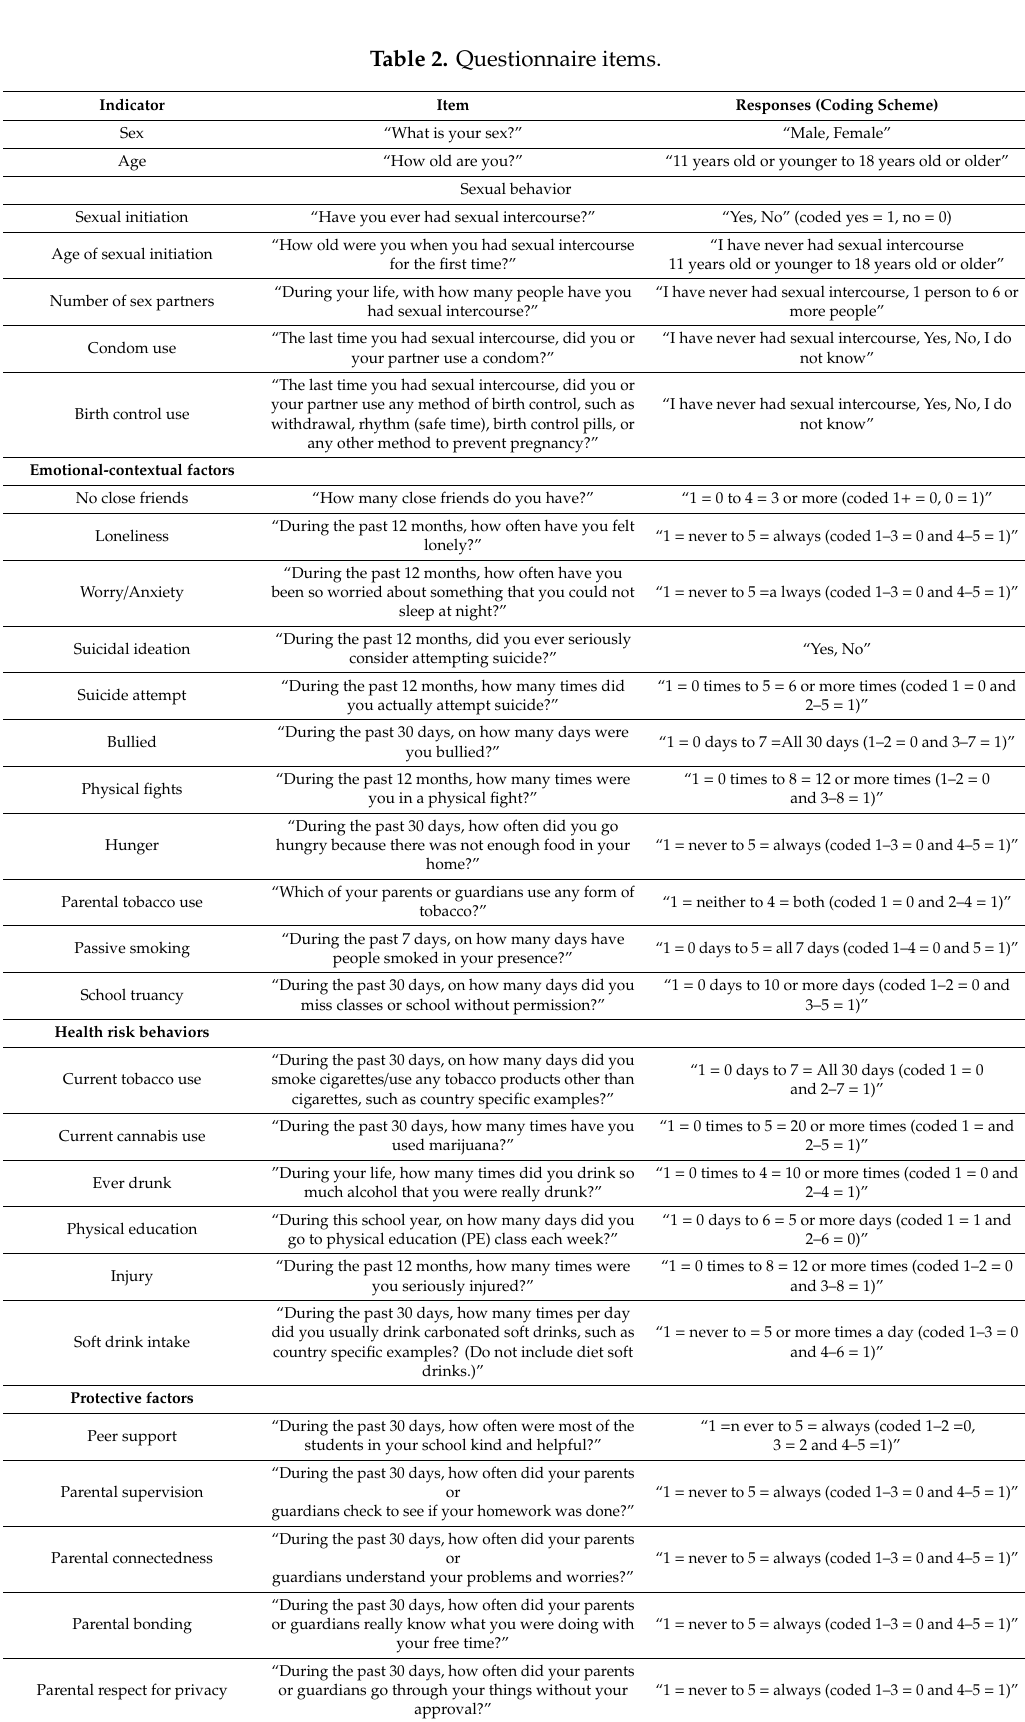
Table 2. Questionnaire